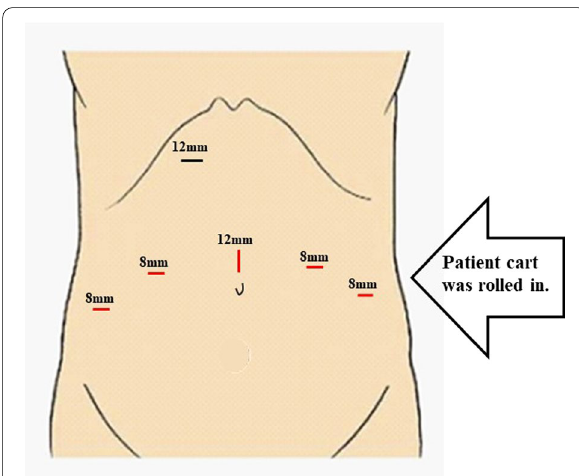
Fig. 2 Schema of port placement. A total of five robotic ports were placed (red line), and another conventional laparoscopic 12-mm port (black line) was inserted in the right upper quadrant by an assistant operator. The Da Vinci Xi ® patient cart was rolled to the left side of the patient only once during